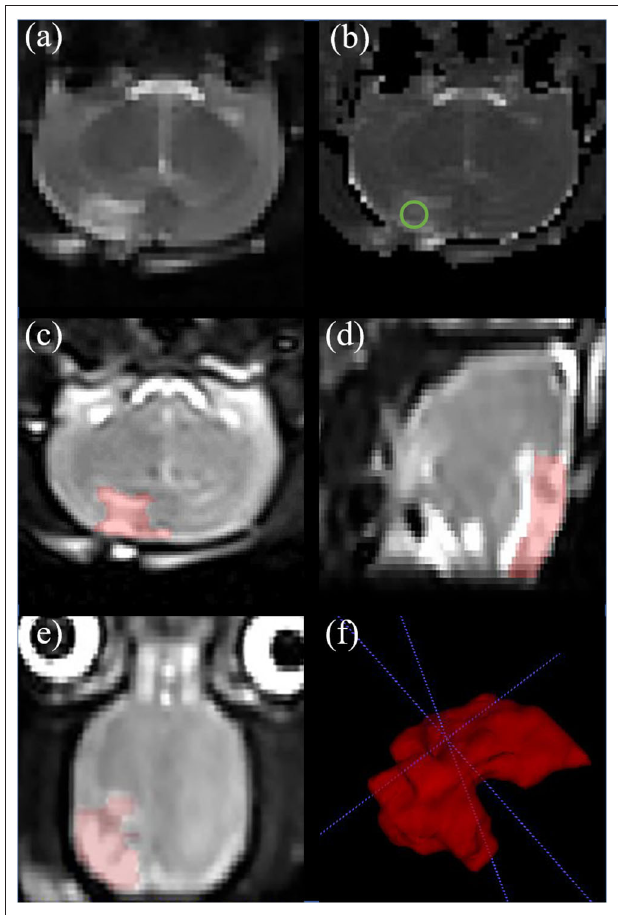
FIGURE 2 | Representative rat brain images of a same rat in TBI group at day 7. (a) Coronal T2-weighted image. (b) T2 map. ROI of injury area (green circle in b ) was chosen on an axial T2 map. (c–e) Iso-voxel 3D T2-weighted image. The red areas represent areas of edema in the brain. Through the application of Paintbrush Mode in ITK-SNAP, the volume of brain edema was obtained. (f) Three—dimensional morphology of cerebral edema after